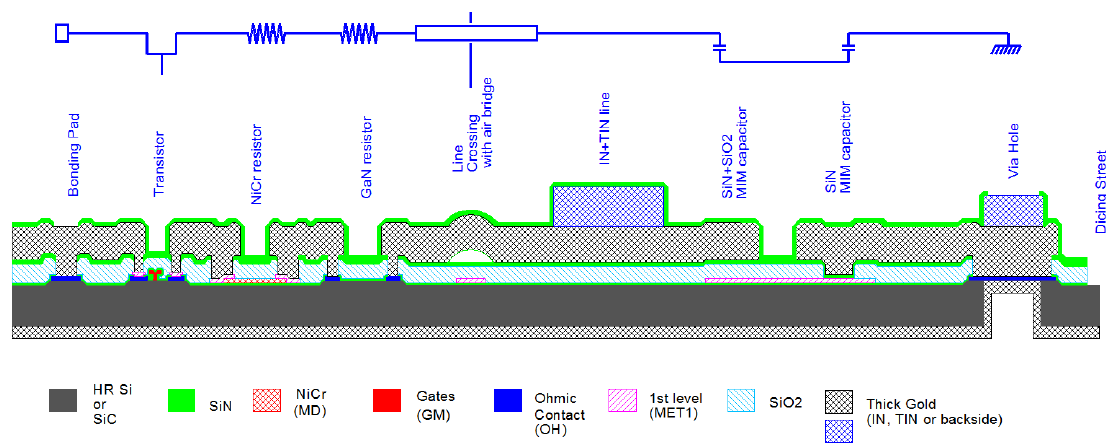
Figure 2. D01GH process cross section.